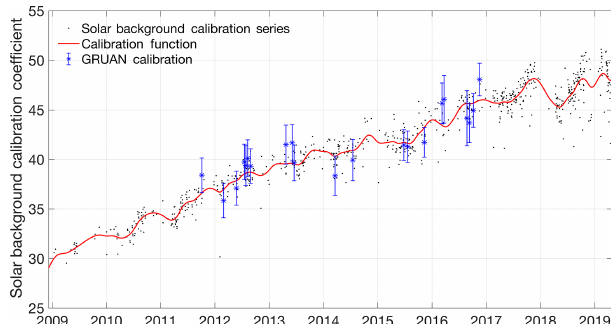
Figure A1. The final normalized calibration time series. Black points are the solar calibration values from January 2009 to Au- gust 2019. Blue points are the trajectory calibration values with their uncertainties. The red line is the smoothing spline fit to the solar calibration